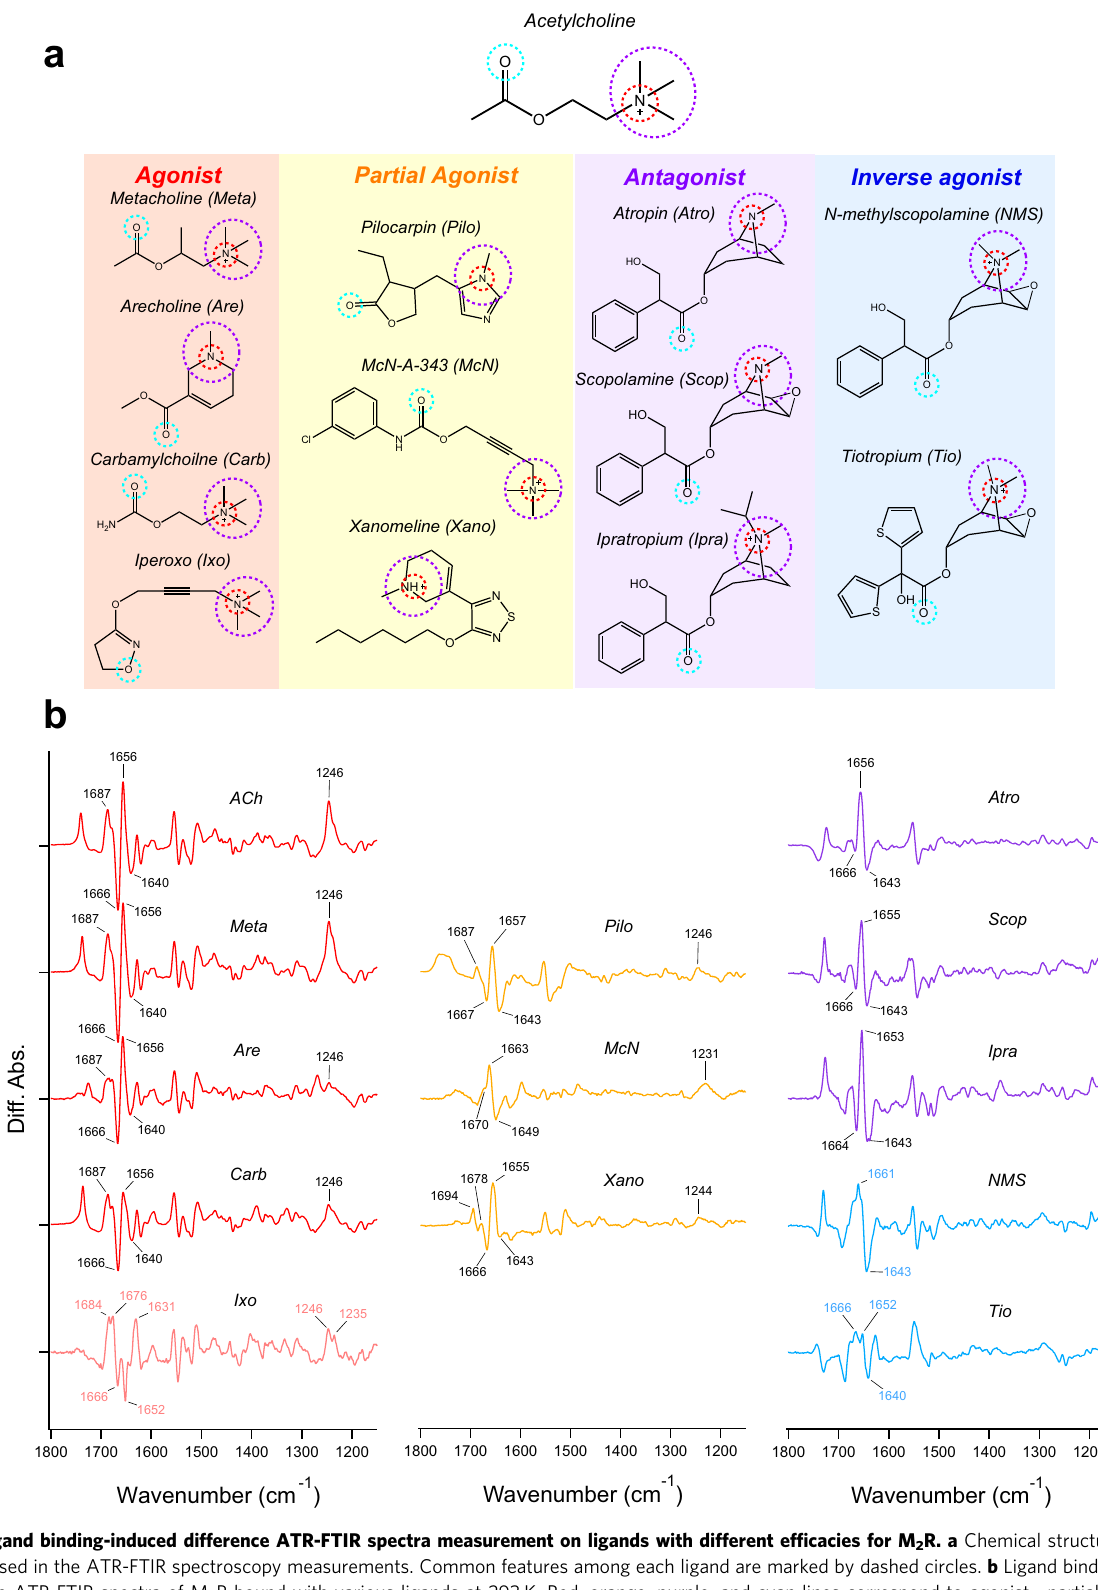
Fig. 1 Ligand binding-induced difference ATR-FTIR spectra measurement on ligands with different ef fi cacies for M 2 R. a Chemical structures of the ligands used in the ATR-FTIR spectroscopy measurements. Common features among each ligand are marked by dashed circles. b Ligand binding-induced difference ATR-FTIR spectra of M 2 R bound with various ligands at 293 K. Red, orange, purple, and cyan lines correspond to agonist-, partial agonist-, antagonist-, and inverse agonist-bound spectra measured in H 2 O, respectively. Positive and negative bands originate from ligand-bound and ligand- unbound states, respectively. One division of the y -axis corresponds to 0.002 absorbance